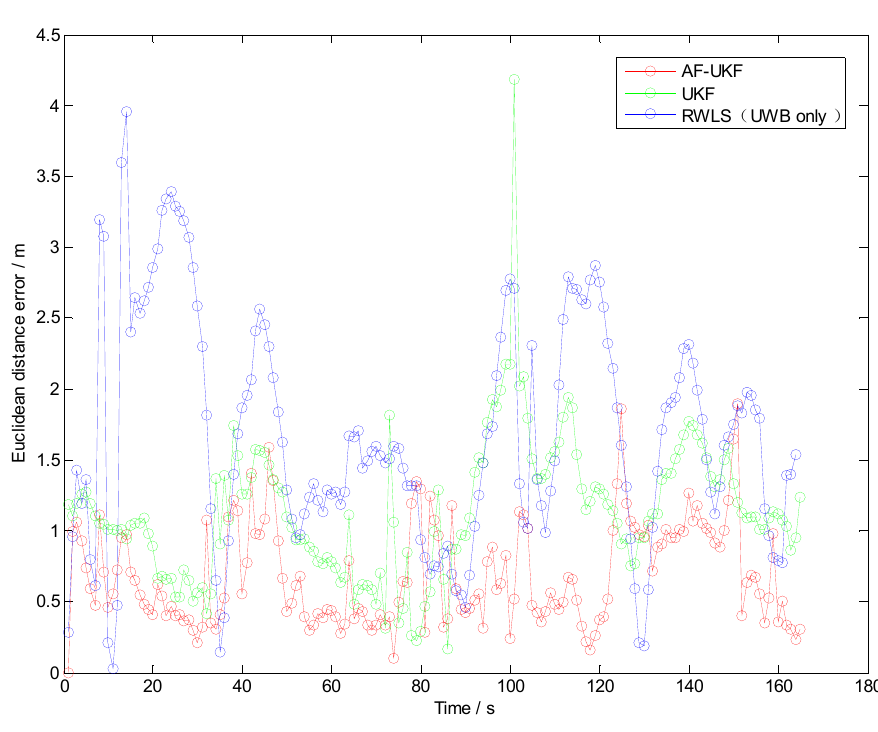
Figure 13. Euclidean distance error in Trajectory V. Table 5. Statistics of Euclidean Distance Errors in trajectory V (m).